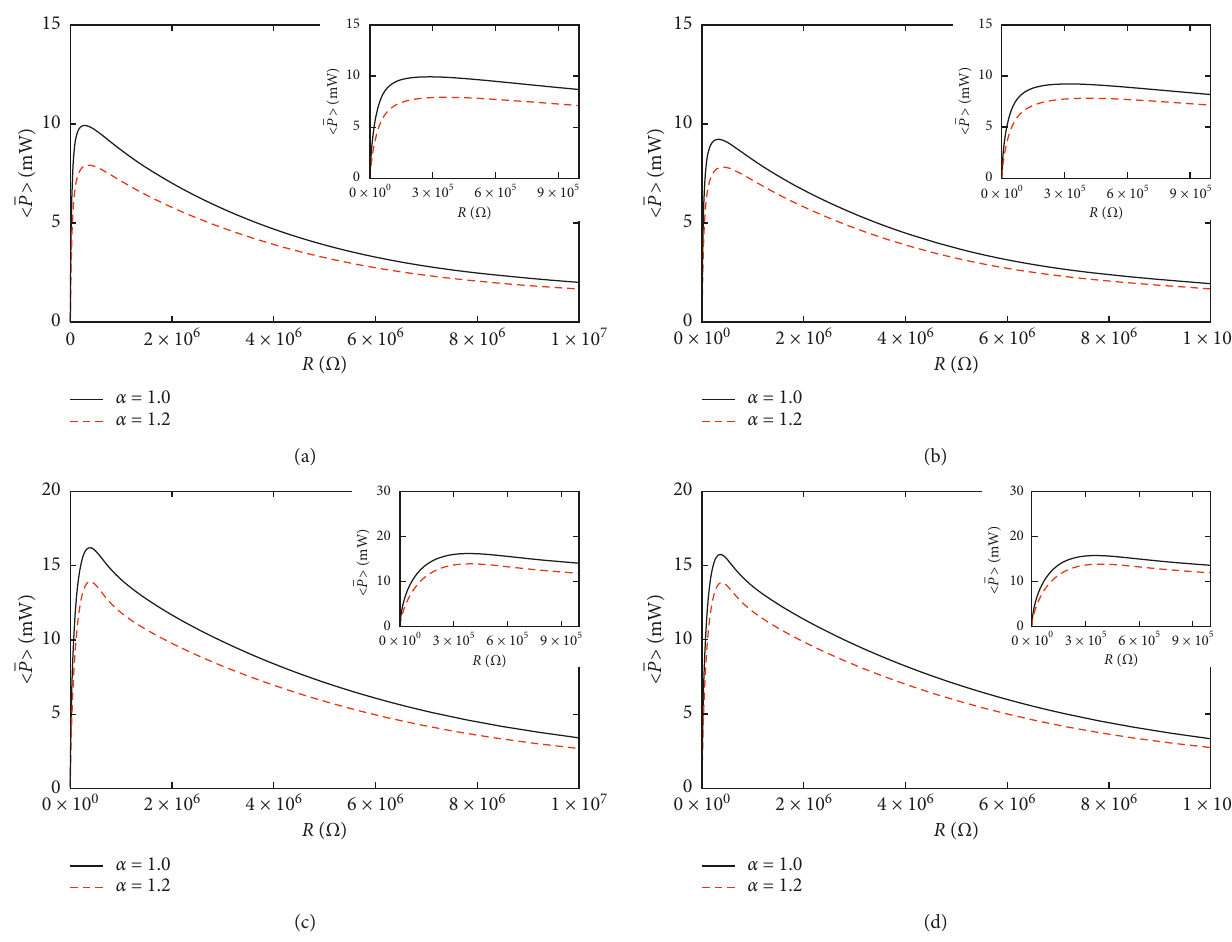
Figure 9: The effective output power generated on the electric load as a function of the load resistance; (a) Δ � 5mm , δ